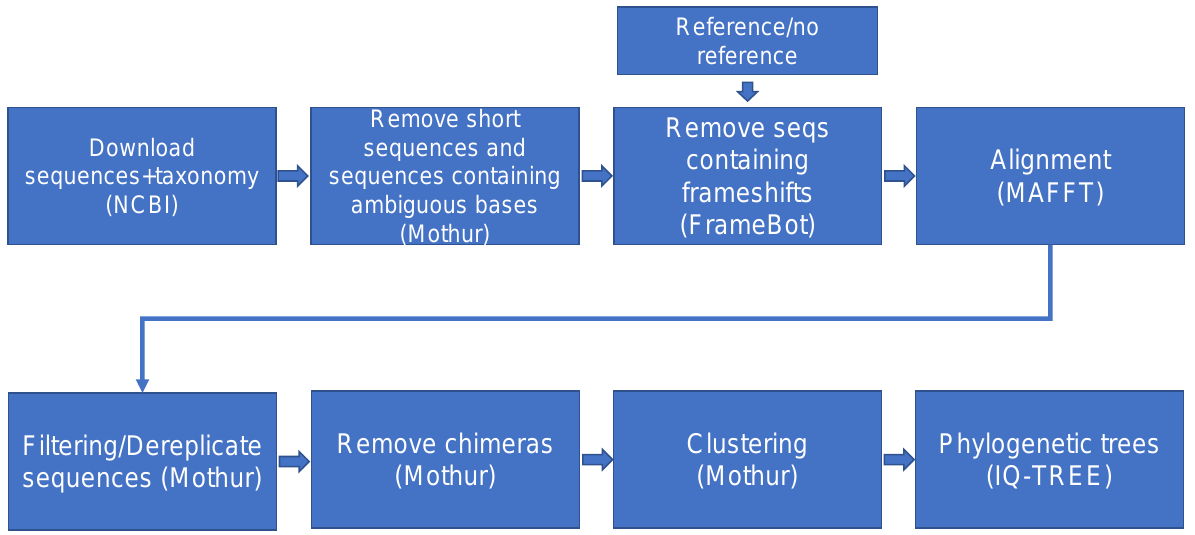
Figure 1. Workflow of the database-producing PhyloFunDb pipeline. Sequence download, processing, filtering, clustering, and tree inference.